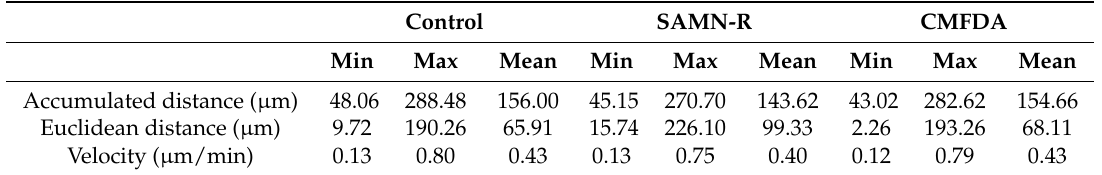
Table 5. Migration of hMSCs in Patient 3 from 50 cells of control, CMFDA-labelled, and SAMN-R treatment groups. The velocity, accumulated, and Euclidean distance values for a six-hour period are shown.